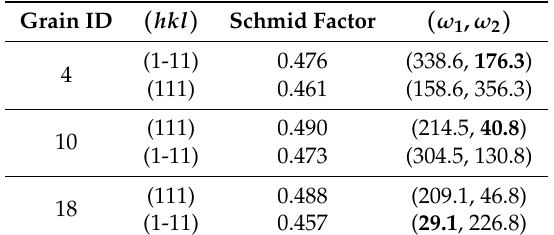
Table 3. Edge-on ω values (in ◦ ) for the two slip systems with the highest Schmid factor in the 3 grains; ω values in bold are used to show the topographs in edge-on configuration in Figure 5.